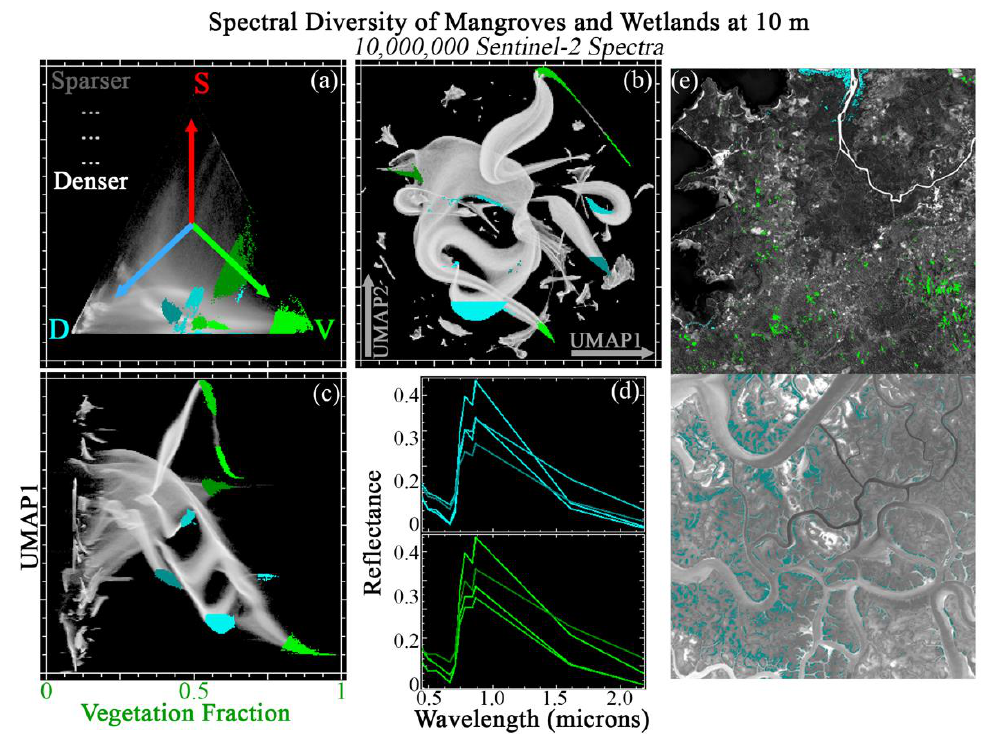
Figure 12. Joint characterization of mangroves and wetlands. 10 × 1 megapixel Sentinel-2 tile subsets are selected from global forest diversity hotpots and analyzed at full 10 m pixel resolution. These spectra preferentially occupy the V to D apexes of the SVD mixing space ( a ), leaving the S portion of the space relatively sparse. The global 3-endmember linear mixture model fits these spectra better than the agricultural spectra (here, > 99.9% of spectra with <5% RMSE). UMAP ( b ) captures both subtle mixing continua and discrete clusters, but does not offer physical interpretability. Joint char- acterization ( c ) uses the physical meaning of the Vegetation mixture fraction to contextualize the subtle statistical relationships captured by UMAP. Example regions of interest are identified from the joint space and projected onto the ternary mixing and UMAP spaces. Mean spectra for each region ( d ) illustrate similarities and differences among statistically distinct clusters. Clusters identi- fied by joint characterization also frequently show geographic coherence ( e ). 3.9. Rocks and Alluvium